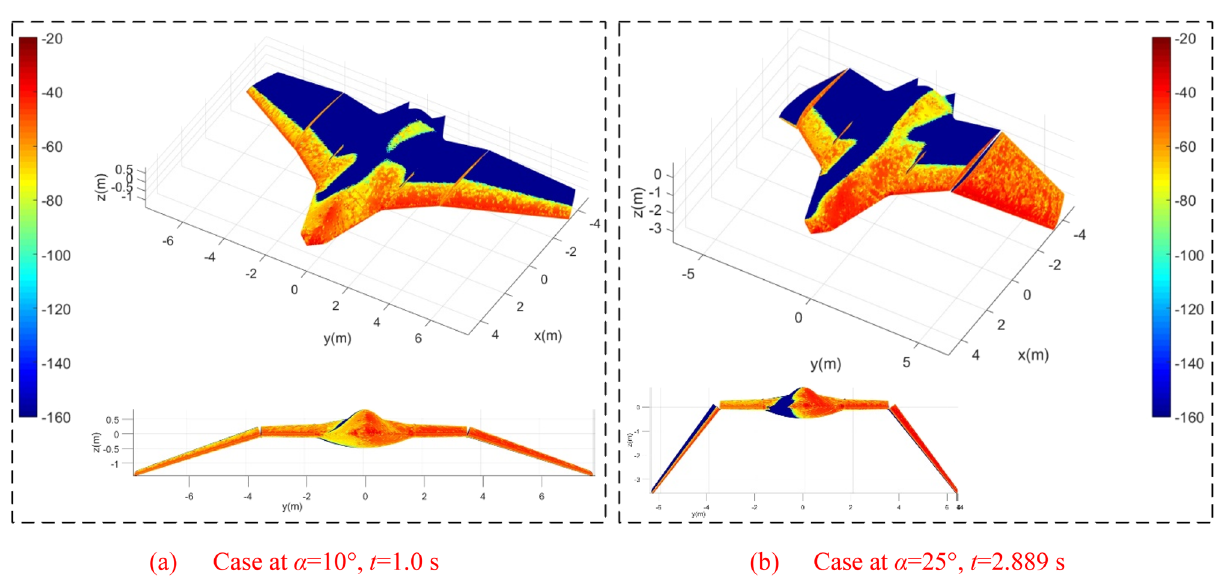
Figure 7. Surface scattering characteristics of aircraft in Z1 mode, β = 0°, f RH = 6 GHz, ω r1 = ω r2 = 0.3142 rad/s, A m1 = A m2 = 0°, RCS unit: dBm 2